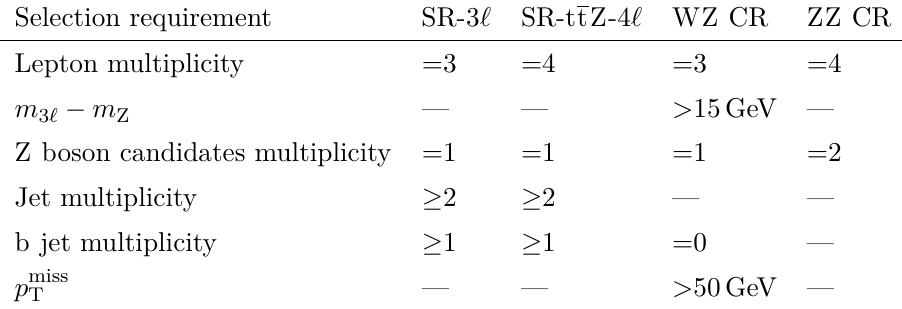
Table 2 . Summary of the main selection requirements applied in each signal or control region. A dash indicates that the selection requirement is not